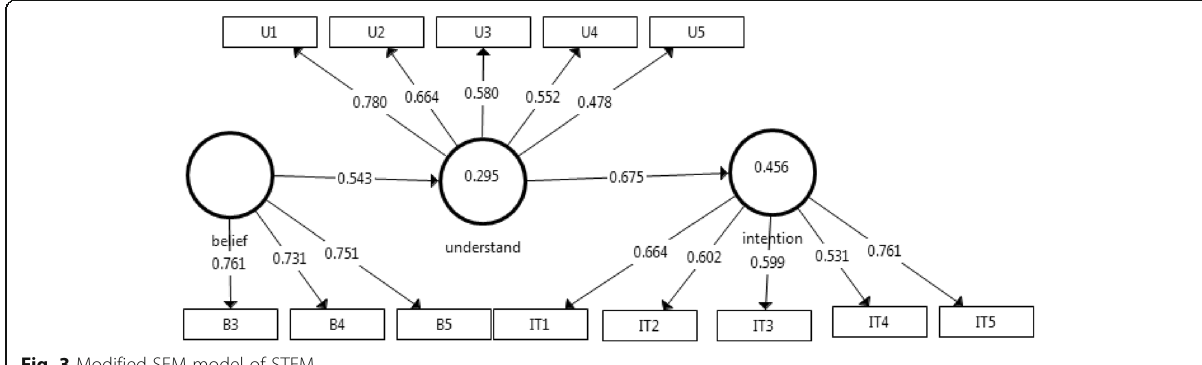
Fig. 3 Modified SEM model of